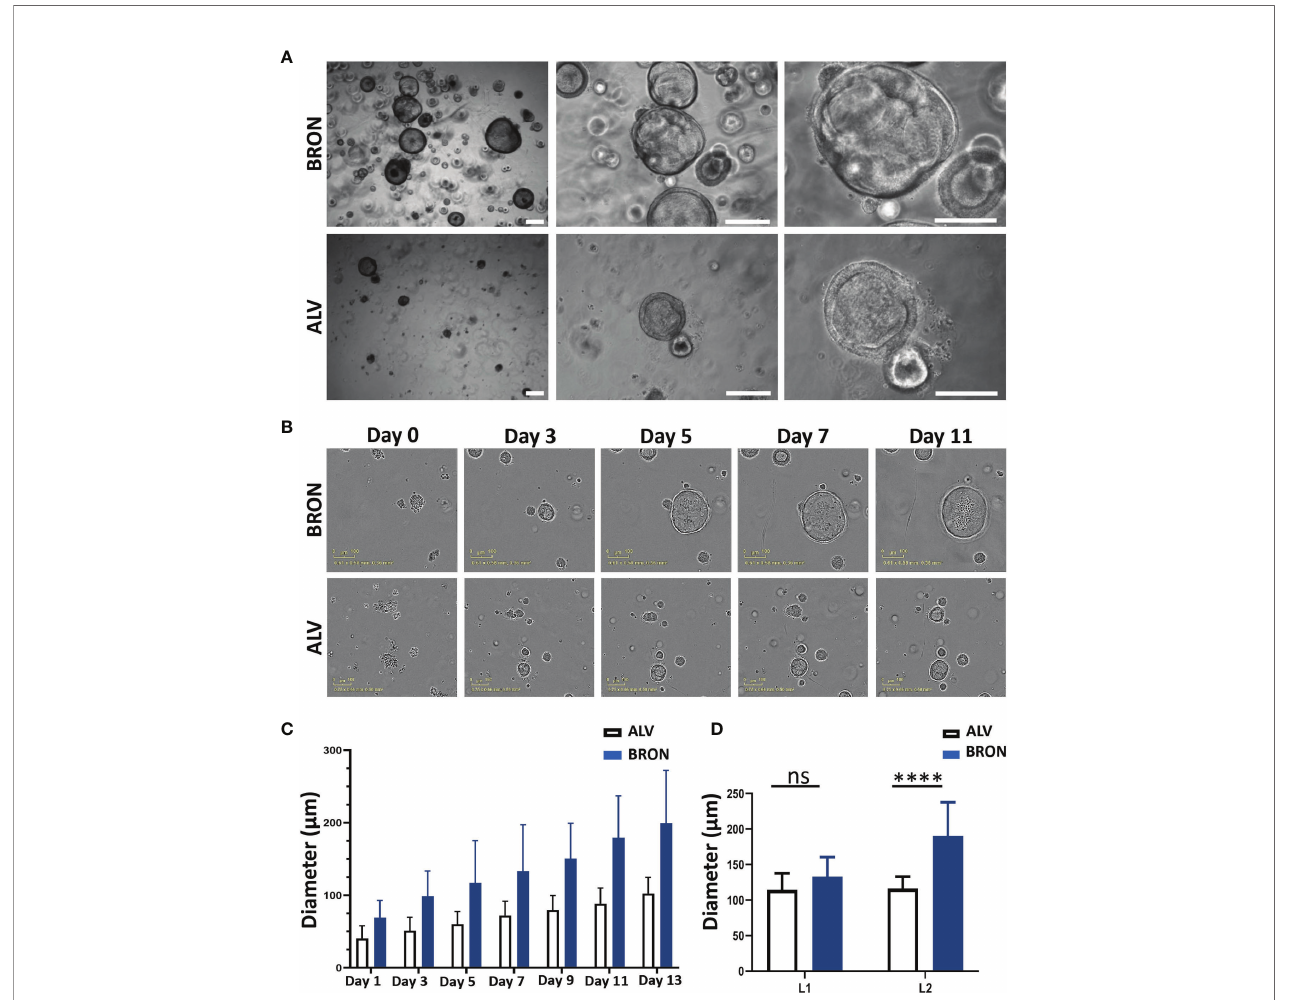
FIGURE 1 | Morphology and growth pattern of established human lung organoids of bronchiolar and alveolar differentiation. (A) Representative bright fi eld images of organoids established in bronchiolar (upper panel) and alveolar (lower panel) differentiation culture media. Magni fi cation, 4x left, 10x middle and 20x right. Scale bars in all images equals 250 µm. The representative images displayed here are from organoids derived from Patient L1. (B) IncuCyte Live Cell analysis system (Sartorius) was applied to assess formation of single cells into alveolar and bronchiolar differentiated organoids for 13 days. Representative images from the IncuCyte time course experiment from day 0 until day 11 is shown. Scale bar equals 100 µm. The representative images displayed here are from organoids derived from Patient L2. Link to time-lapse video showing the organoid formation in alveolar and bronchiolar differentiation media of this IncuCyte time-lapse experiment is available in Supplementary Materials (VIDEO S1 and S2) . (C) IncuCyte images of organoids from panel B were used to measure the average diameter of 10 individual alveolar and bronchiolar organoids, over 13 days, using the built-in measure tool in ImageJ. The 10 largest organoids were measured for each condition. (D) Quanti fi cation of organoid diameter from H&E-stained images from passage 2 organoids embedded at day 14 after passaging cultured in bronchiolar and alveolar differentiation medium from patients L1 and L2 was performed using the built-in measure tool in ImageJ. The ten biggest organoids were measured for each condition. Representative H&E images from patient L2 are shown in panel B (bronchiolar) and 4B (alveolar). The Mann-Whitney test was used to compare organoid diameter between ALV and BRON (ns in L1, **** P < 0.0001 in